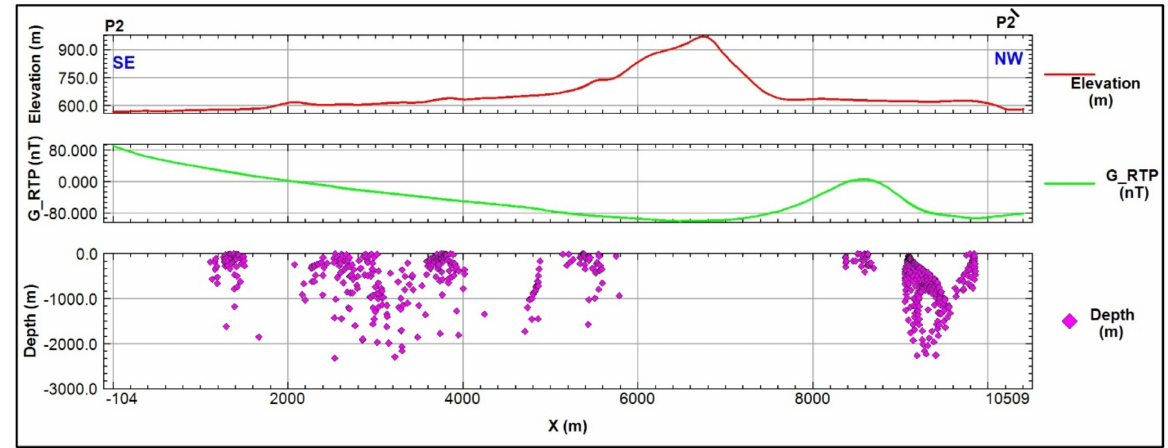
Figure 10. Analytical signal technique for aeromagnetic profile (P2) of Homrit Waggat area, Central Eastern Desert, Egypt.